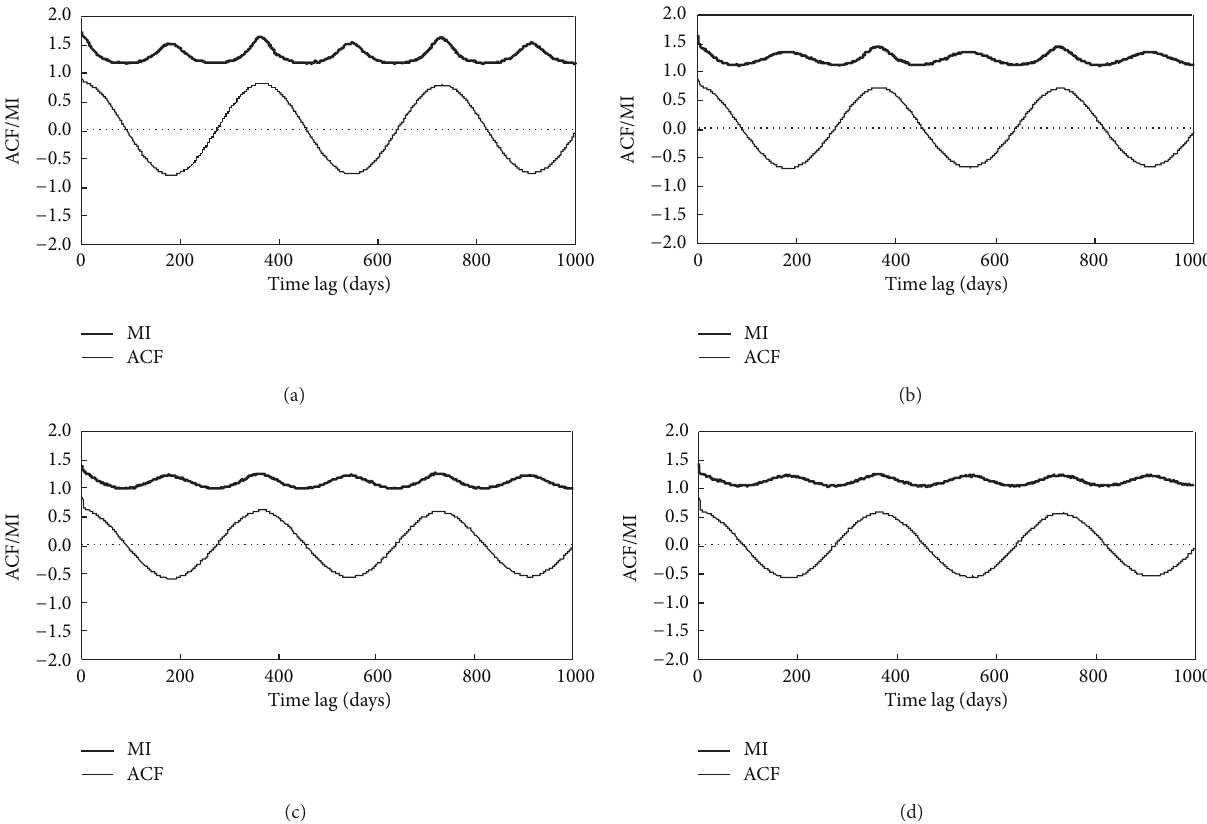
Figure 4: ACF and MI of daily reference evapotranspiration: (a) Baotou station; (b) Zhangbei station; (c) Kaifeng station; (d) Shaoguan